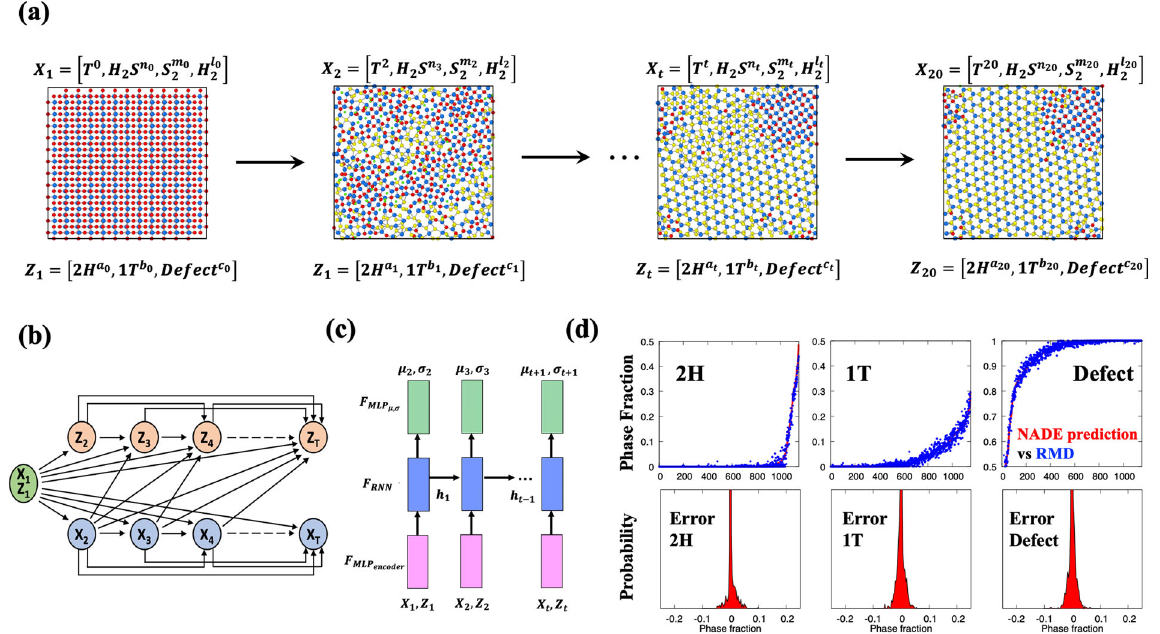
Fig. 2 NADE model of computational synthesis of MoS 2 . a Each 1-ns step of the RMD simulation is characterized by an input vector X i characterizing the synthesis conditions and the distribution of phases in the resulting structure, Z i . b Bayesian Network representation of CVD synthesis of MoS 2 over T max = 20 ns. The green and blue nodes are synthesis condition as observed variables ( X n ), whereas orange nodes are unobserved ( Z n ), which represents phase fraction of 2H, 1T and defect in MoO x S y surface as a function of time. c Schematic of the NADE-CVD, composed of two multi-layer perceptrons F MLP as encoder and decoder networks and an intermediate recurrent neural network block, F RNN . d Test accuracy of NADE-CVD with a mean absolute error <0.1 phase